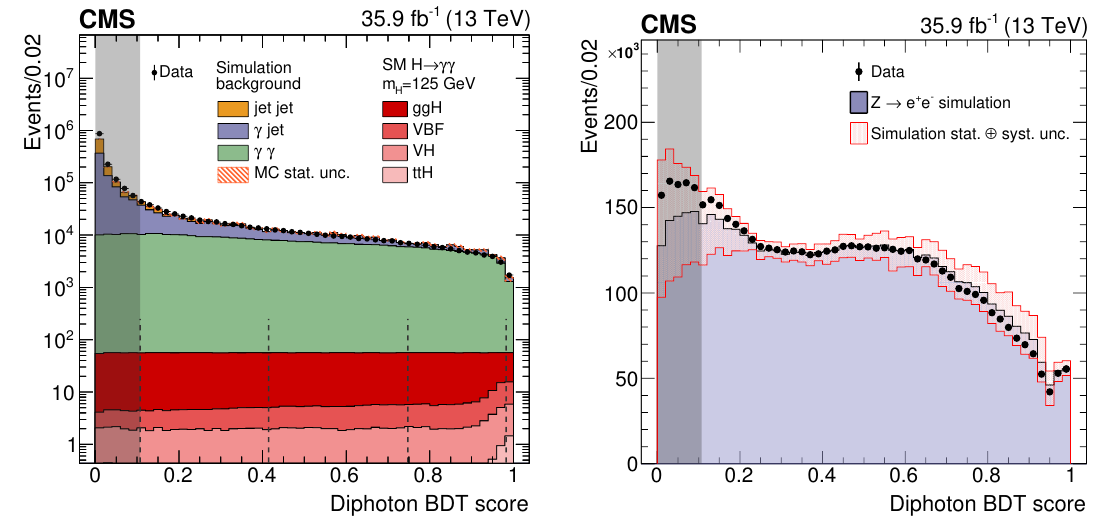
Figure 5 . (Left) Transformed score distribution from the diphoton multivariate classi(cid:12)er for events with two photons satisfying the preselection requirements in data (points), simulated signal (red shades), and simulated background (coloured histograms). Both signal and background are stacked together. The vertical dashed lines show the boundaries of the untagged categories, the grey shade indicates events discarded from the analysis. (Right) Score distribution of the diphoton multivariate classi(cid:12)er in Z ! e + e (cid:0) events where the electrons are reconstructed as photons. The points show the distribution for data, the histogram shows the distribution for simulated Drell-Yan events. The pink band indicates the statistical and systematic uncertainties in simulation. The grey shade indicates events discarded from the